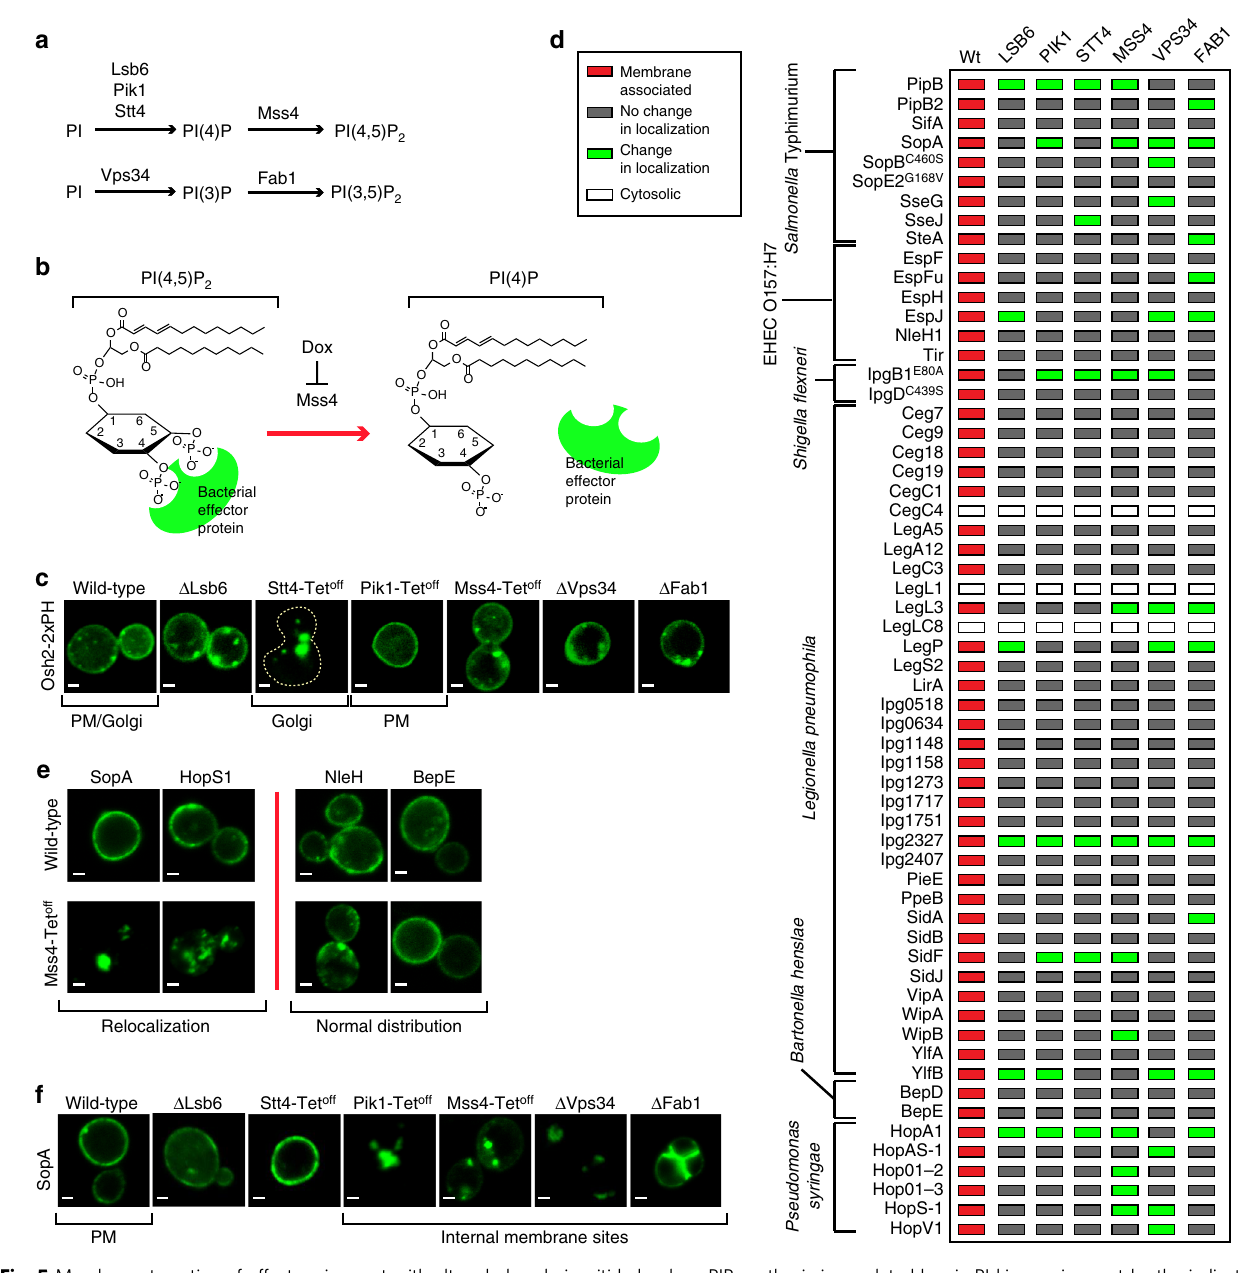
Fig. 5 Membrane targeting of effectors in yeast with altered phosphoinositide levels. a PIP synthesis is regulated by six PI-kinases in yeast by the indicated pathways. b Design of the PI kinase screen. Genetic deletion or doxycycline repression of each PI kinase (Mss4 shown) depletes the PIP, causing loss of localization of effectors that have a membrane localization governed by PI(4,5)P 2 . c Localization of EGFP-Osh2 (a known PI4P binding protein) in wild-type S. cerevisiae cells and the six PI kinase yeast strains. d Graphical representation of all the membrane-associated effectors localization upon depletion of each of the six PI-kinases compared to localization in wild-type yeast (Supplementary Fig. 1). e Representative images of plasma membrane-localized effectors that were redistributed when MSS4 was repressed by the presence of doxycycline (example: SopA St and HopS1 Ps ), or did not redistribute with MSS4 repression (example: NleH Ec and BepE Bh ). Scale bar is 1 μ m. f Fluorescent images of GFP-fused SopA St in wild-type S. cerevisiae cells and the six PI kinase yeast strains. Scale bar is 1 μ